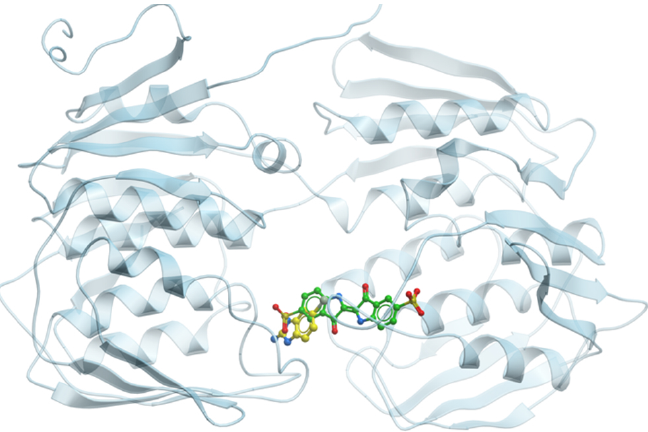
Figure A1. A putative MurA inhibitor S17 binds MurA substrate-binding site. The compound S17 (yellow) and original substrate of MurA, UNAG (Green), was docked into the MurA enzyme (sky blue).